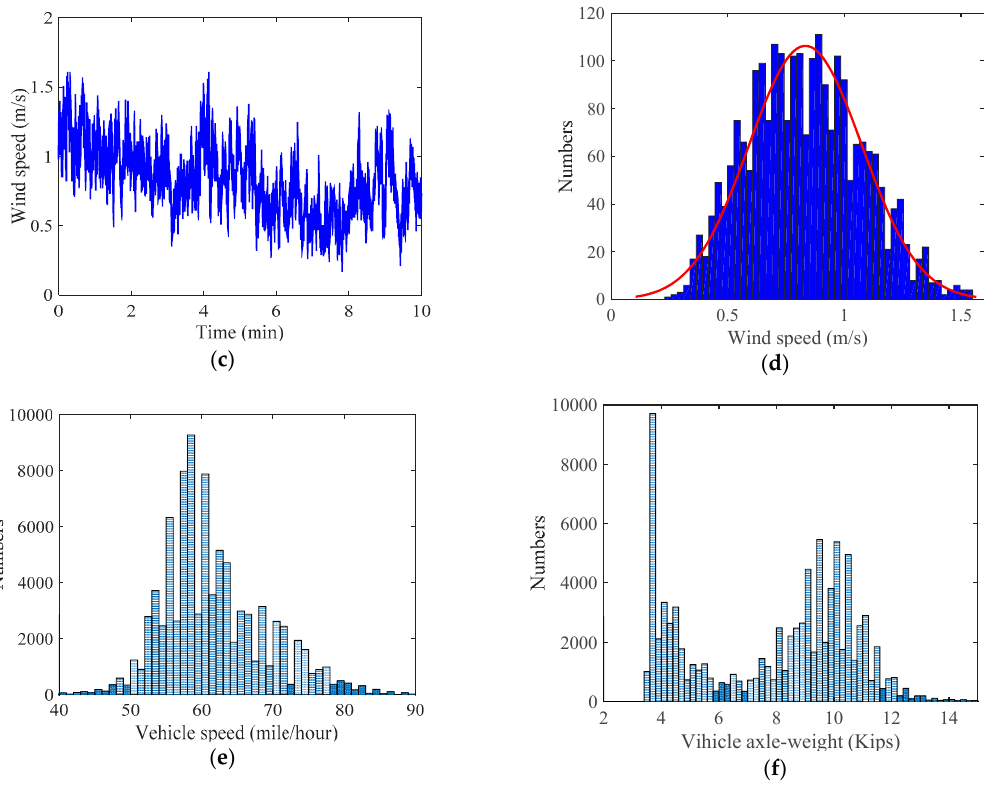
Figure 10. Monitoring interface: ( a ) observed deformation; ( b ) temperature; ( c ) time-history wind speed; ( d ) statistical analysis of wind speed; ( e )statistical analysis of vehicle speed; ( f ) statistical analysis of vehicle axle-weight.